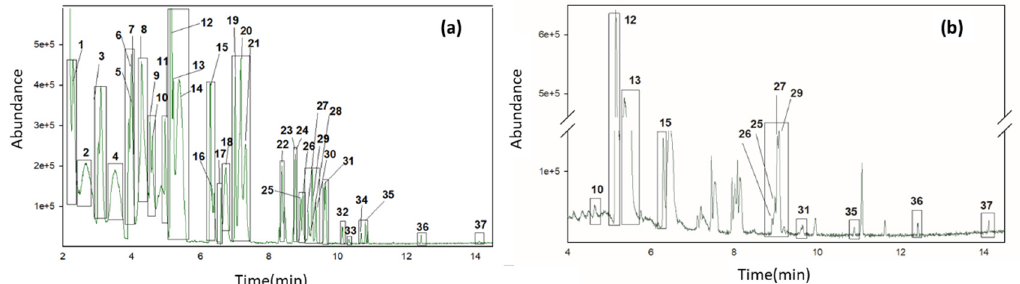
Figure 1. Total ion chromatogram (TIC) of a standards mixture ( a ) and an extra virgin olive oil (EVOO) sample ( b ) showing the volatile compounds identified by headspace gas chromatography (HS-GC) coupled with mass spectrometry (MS): (1) ethyl acetate, (2) 2-butanone, (3) 2-pentanone, (4) 1-penten-3-one, (5) 2-methyl-1-butanol, (6) 3-methyl-1-butanol, (7) 4-methyl-pentan-2-one, (8) trans- 2-pentenal, (9) 1-pentanol, (10) cis-2-penten-1-ol, (11) 2-hexanone, (12) n-octane, (13) hexanal, (14) ethyl butyrate, (15) trans-2-hexen-1-al, (16) ethyl isovalerate, (17) 1-hexanol, (18) trans-2-hexen-1-ol, (19) 2-heptanone, (20) propyl butyrate, (21) heptanal, (22) trans-2-heptenal, (23) 1-octen-3-one, (24) 1- octen-3-ol, (25) 6-methyl-5-hepten-2-one, (26) 2-octanone, (27) 2-octanol, (28) octanal, (29) 3-hexenyl- acetate, (30) hexyl acetate, (31) limonene, (32) trans-2-octenal, (33) 1-octanol, (34) 2-nonanone, (35) nonanal, (36) decanal, (37) trans-2-decenal, (38) diethyl phthalate.